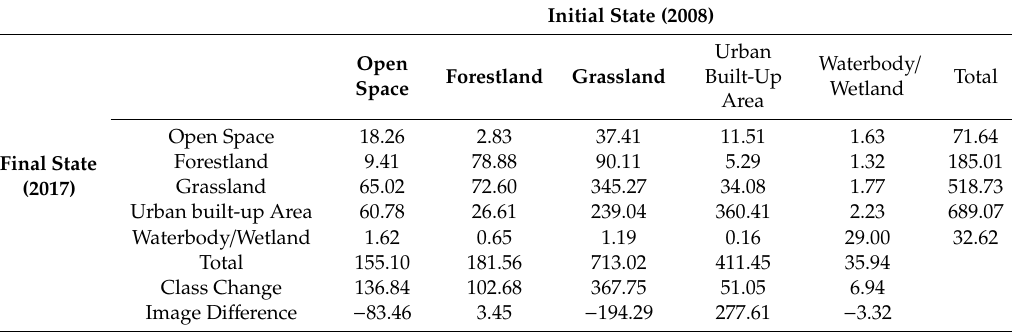
Table 2. The conversion matrix of land-use change classes from 2008 to 2017 (unit: km 2